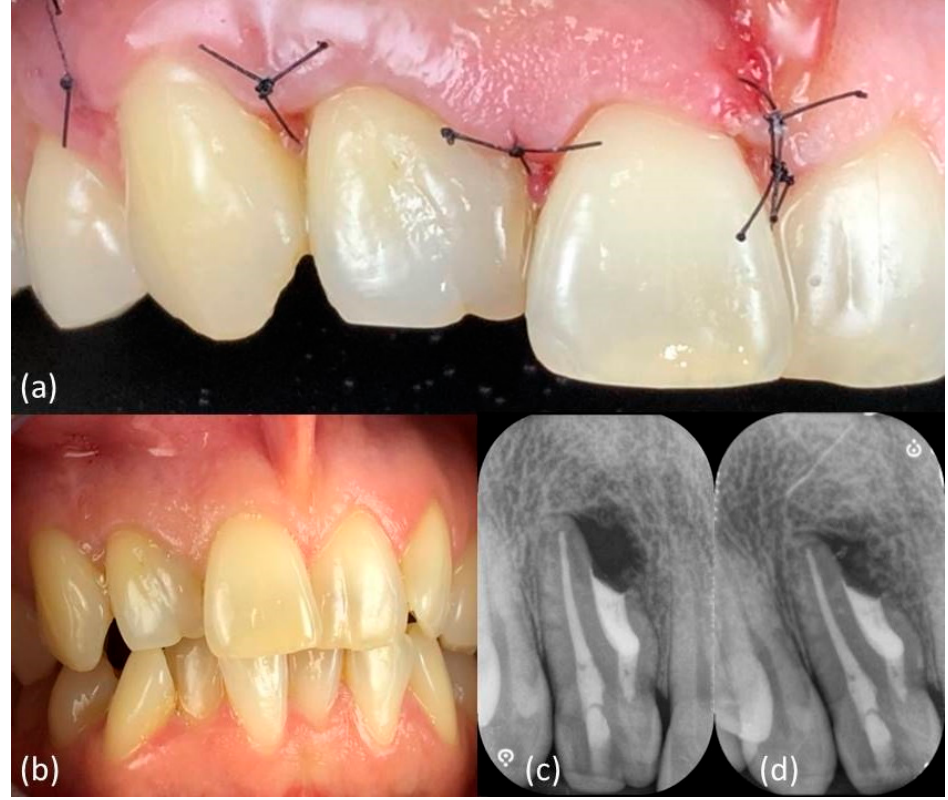
Figure 5. Tissue healing after ( a ) one week and ( b ) six months and ( c ) six-months and ( d ) twelve- months radiographic